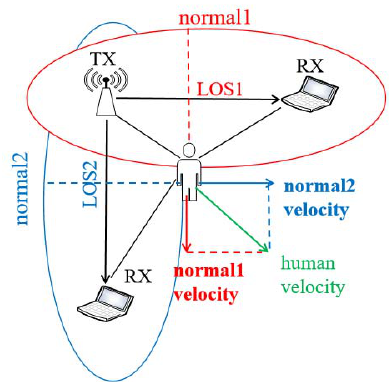
Figure 8. Doppler effect on multiple directions.